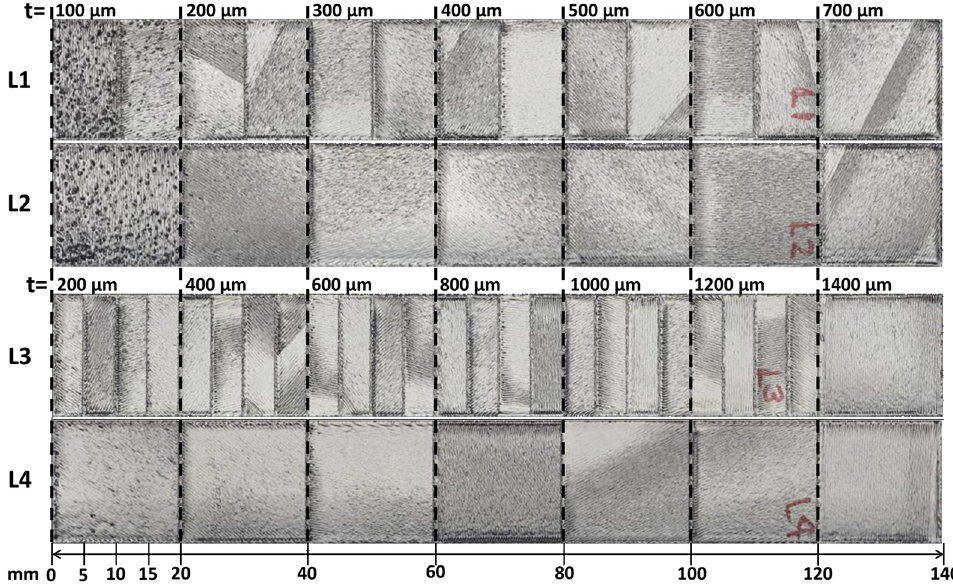
Figure 7. Set 1 of 4 step and ramp specimens, L1 through L4, from top to bottom, with the designed thickness indicated in black text starting at the dashed lines.